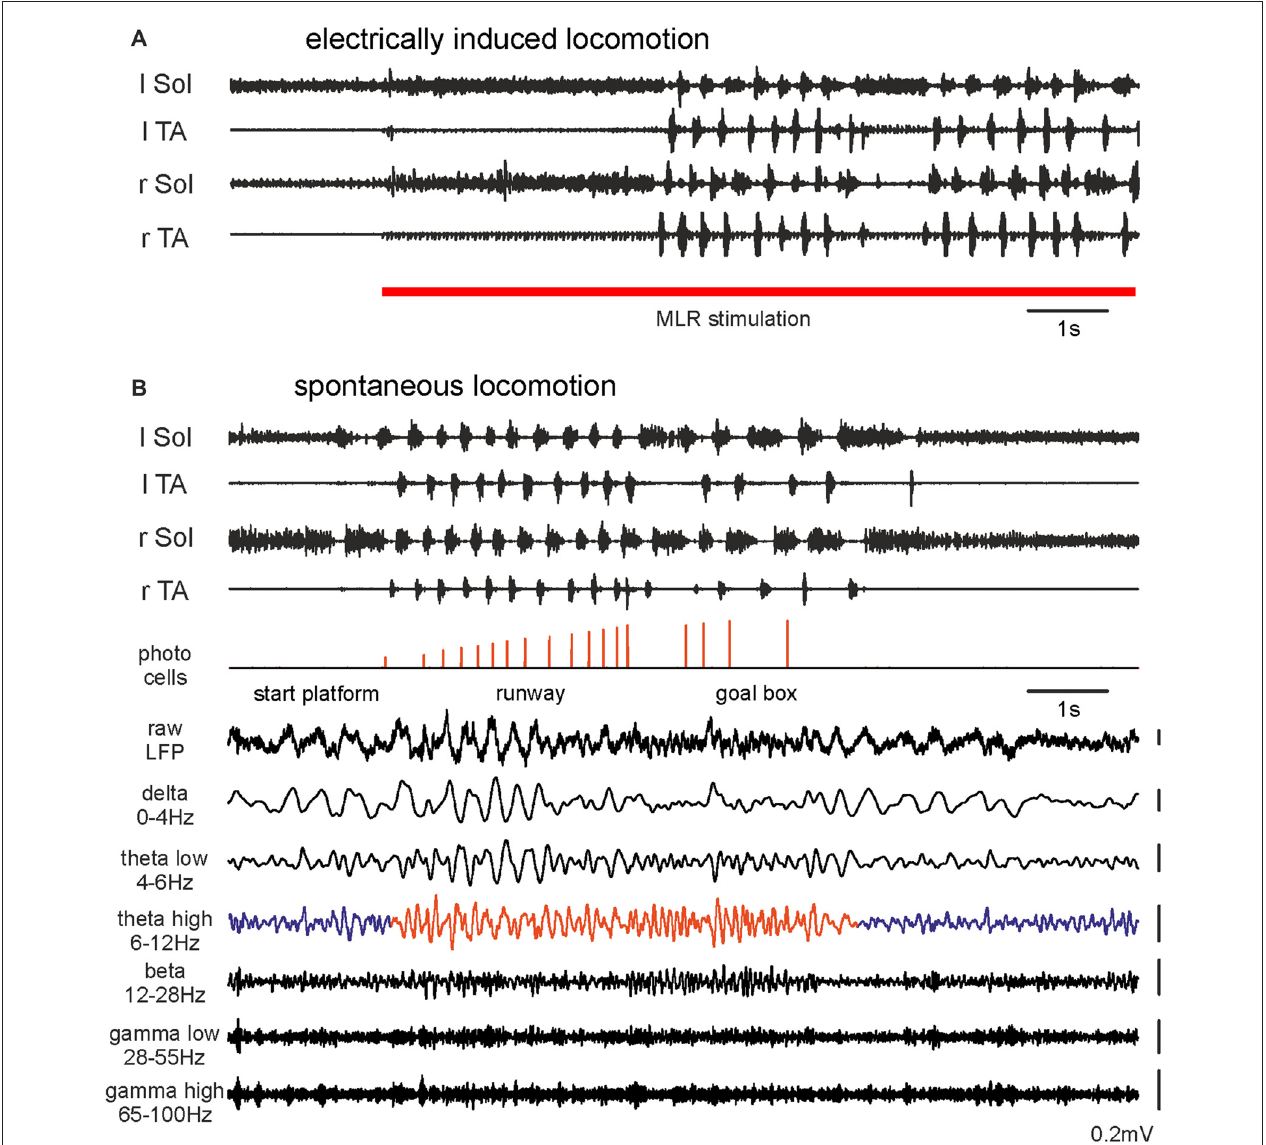
FIGURE 1 | Hindlimb muscle electromyography (EMG) and mesencephalic locomotor region (MLR) LFP activity during transition from resting to walking: (A) A rat with motor activity induced by right MLR electrical stimulation (28 µ A, 20 Hz, 0.5 ms pulse duration). (B) The same rat walking spontaneously along a 2 m runway. Photocells events with increasing pulse amplitudes show progression along the runway. The bottom traces show simultaneously occurring raw LFP recorded from the right MLR and successive activity in filtered frequency bands. Abbreviations: Sol, Soleus muscle; TA, Tibialis Anterior muscle; r, right; l, left; LFP, local field